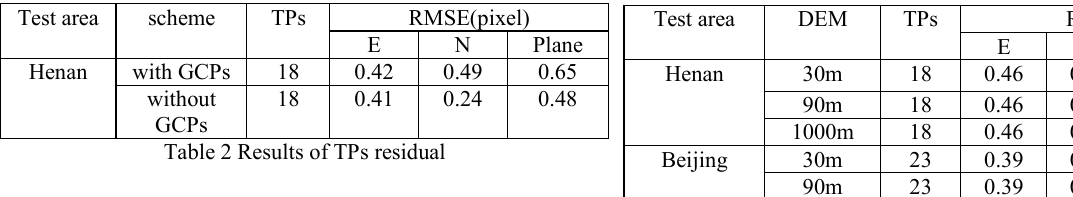
Table 1. Accuracy of stitching with and without GCPs